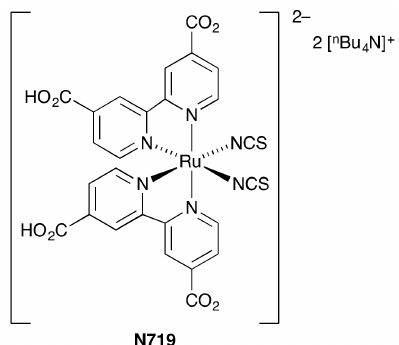
Scheme 1. Structure of the ruthenium dye